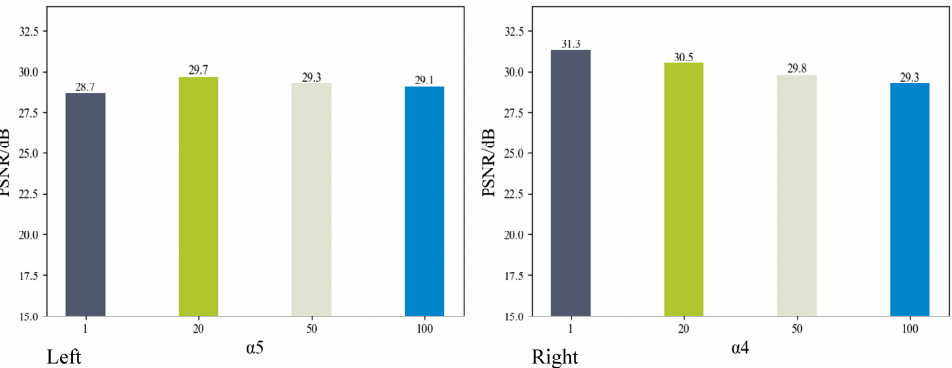
Figure 12. Analysis of the influence of different hyper parameter values in the proposed method on the performance. the